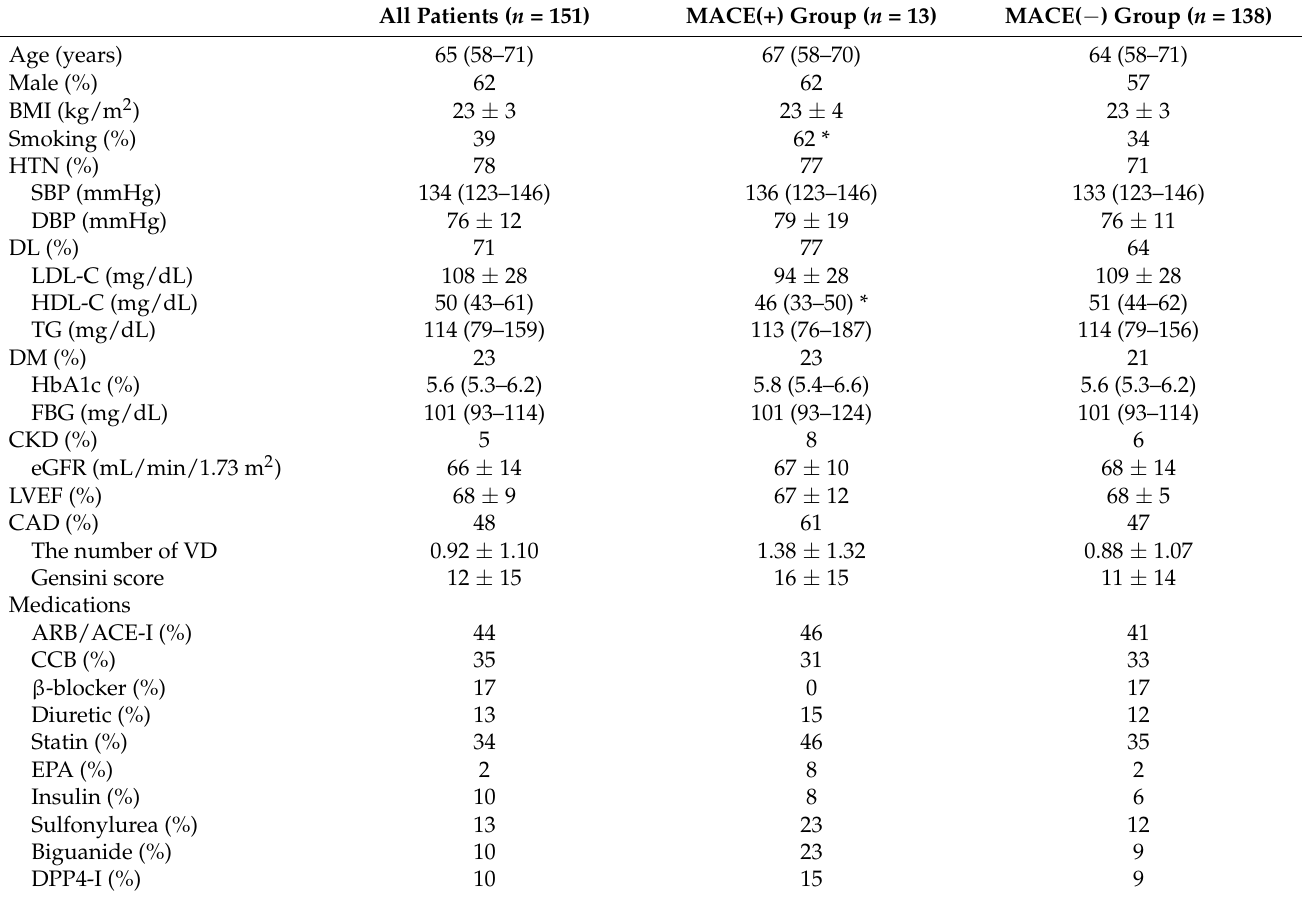
Table 1. Patient characteristics in all patients, the MACE(+) group and the MACE( − ) group. All Patients ( n =